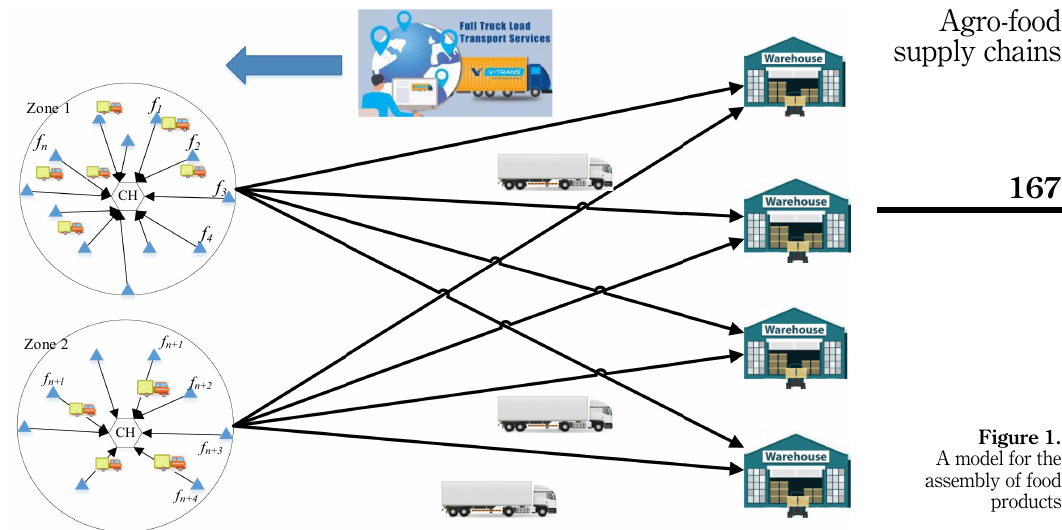
Figure 1. A model for the assembly of food